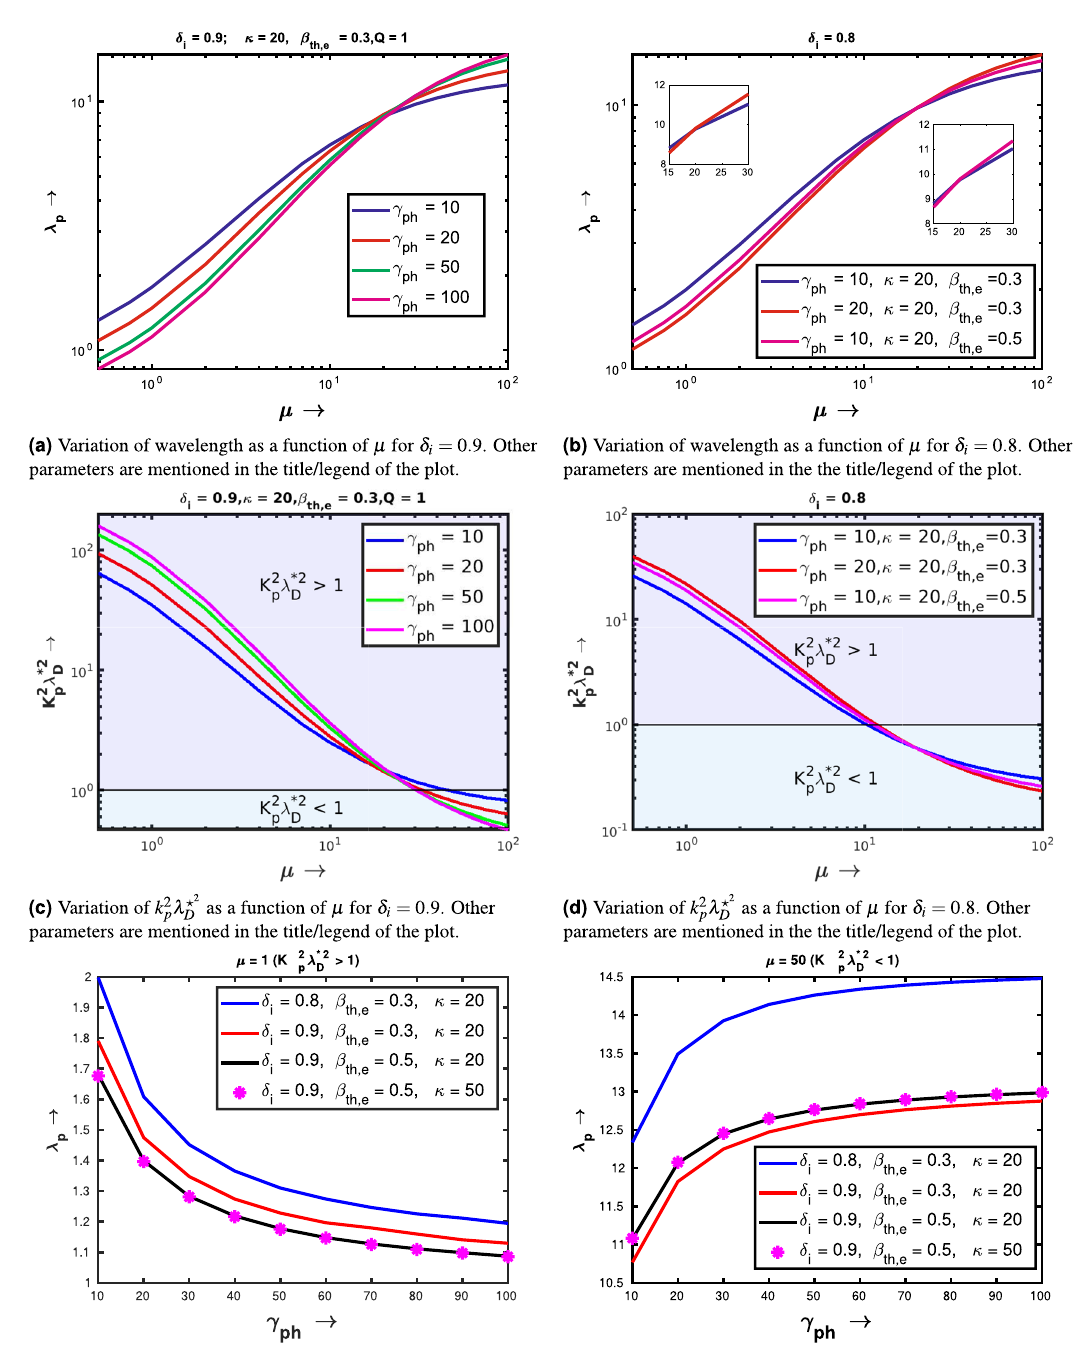
2 D for relativistic electrostatic waves in an